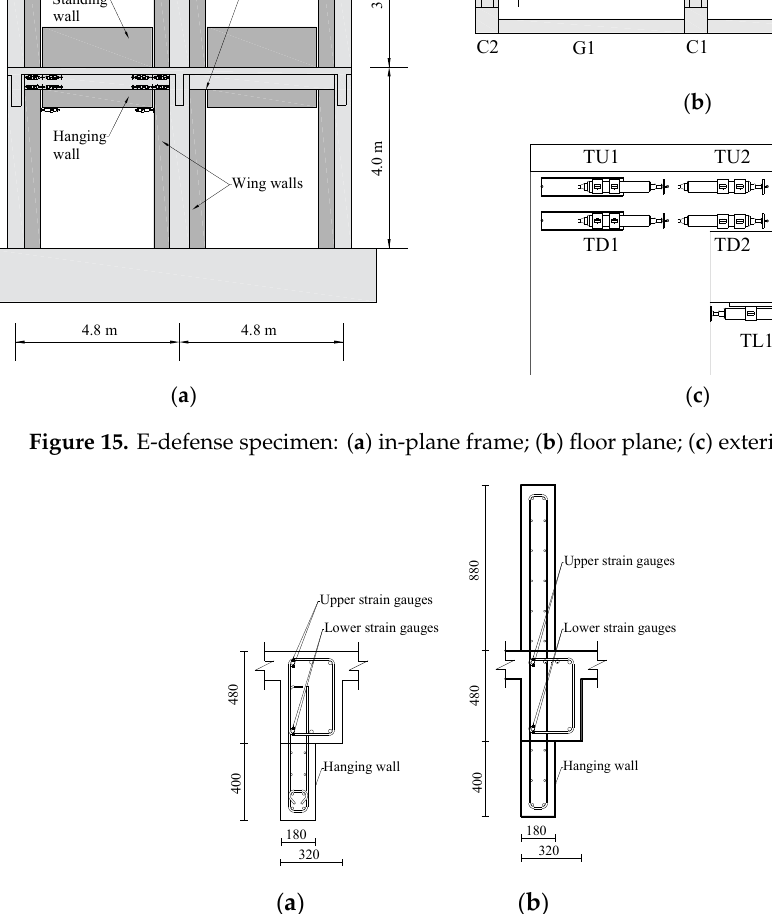
Figure 16. Cross section of the hanging wall: ( a ) NW18; ( b ) ZW18, Unit: mm.